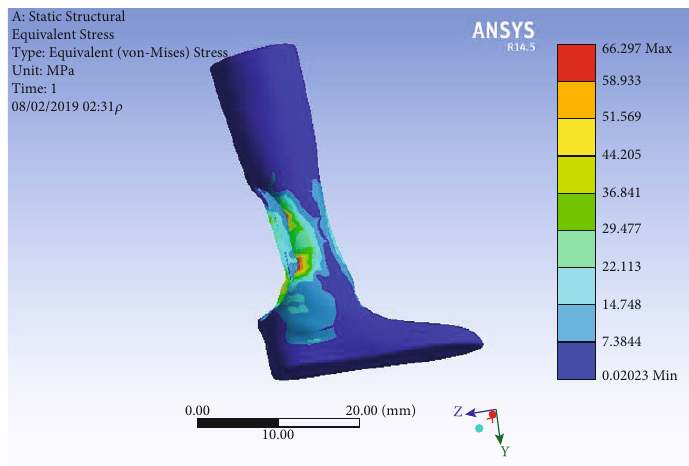
Figure 19: Equivalent stress (von Mises) in group C.